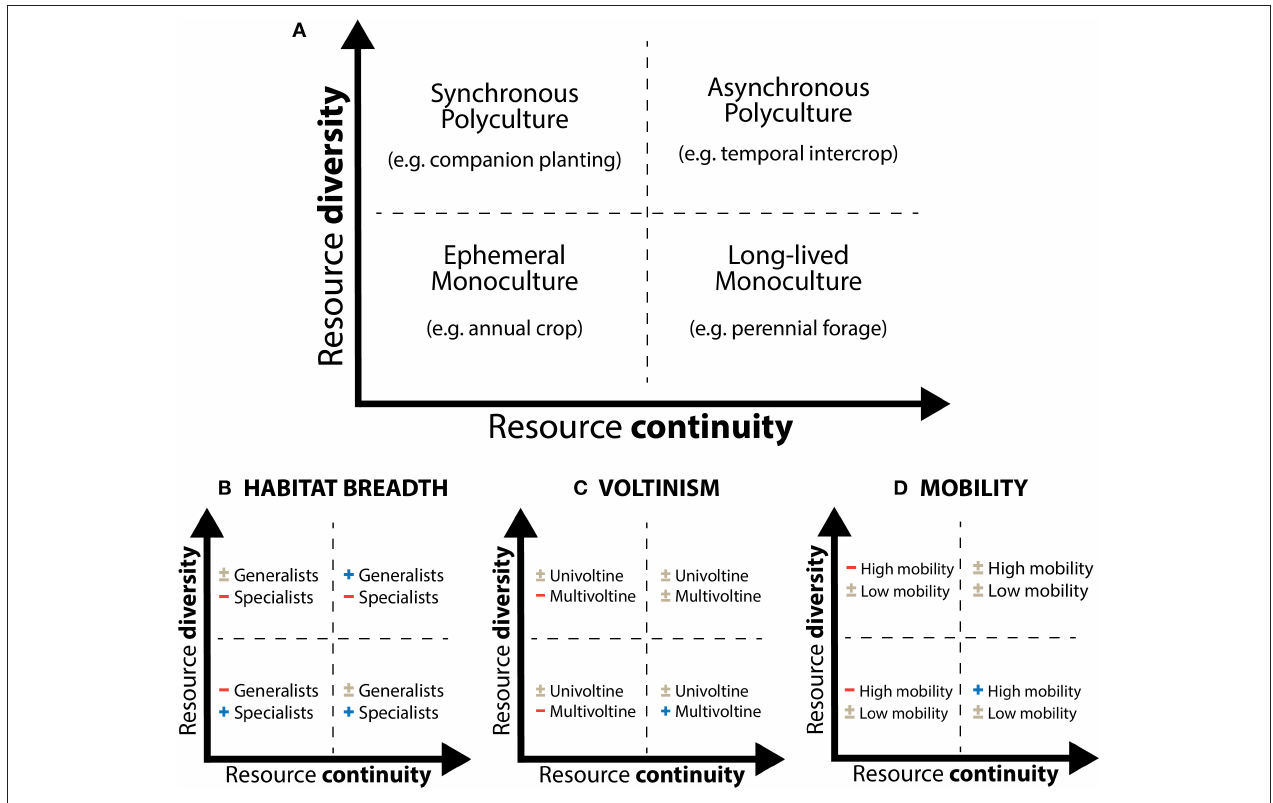
FIGURE 3 | Framework for analyzing resource patterns in agroecosystems incorporating both diversity and continuity dimensions. (A) Depicts four broad agroecosystem types in each quadrant. (B–D) Speculate how different arthropod life history traits (habitat/diet breadth, voltinism, and mobility) may interact with resource conditions. Symbols correspond to expectations of positive ( + ), negative (–), or mixed effects ( ± ) on species with a given life history